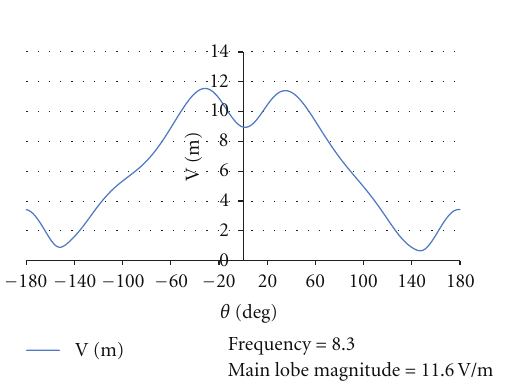
Figure 13: E-field pattern.